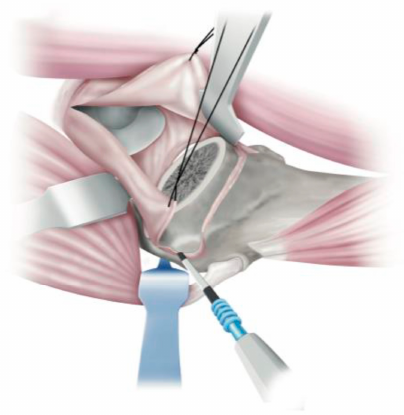
Figure 2. Incision of the superior band of the iliofemoral ligament. A Hohmann hook can be placed immediately proximal to the Gmin attachment site to prevent damage to the Gmin and effectively retract it. The superior band of the iliofemoral ligament (SBILFL) is incised over the lateral intertrochanteric